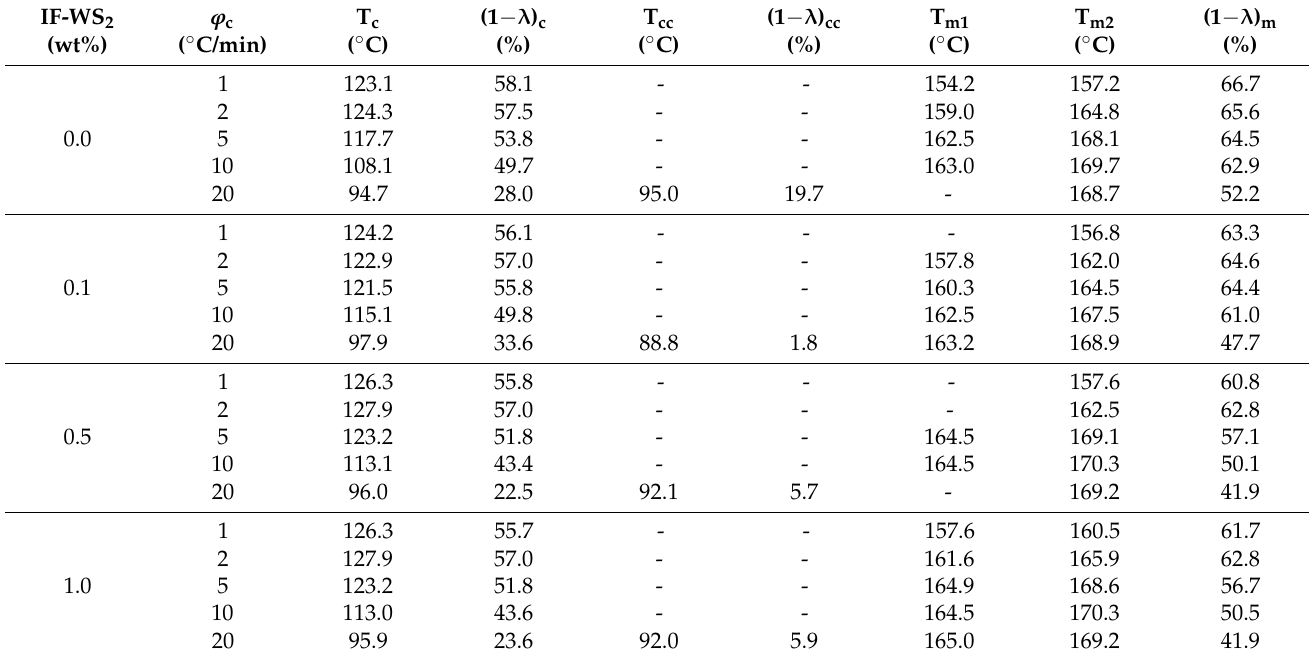
Table 1. Melt–crystallization and melting parameters of the neat PLLA and PLLA/IF-WS 2 nanocomposites. IF-WS 2 (wt%)